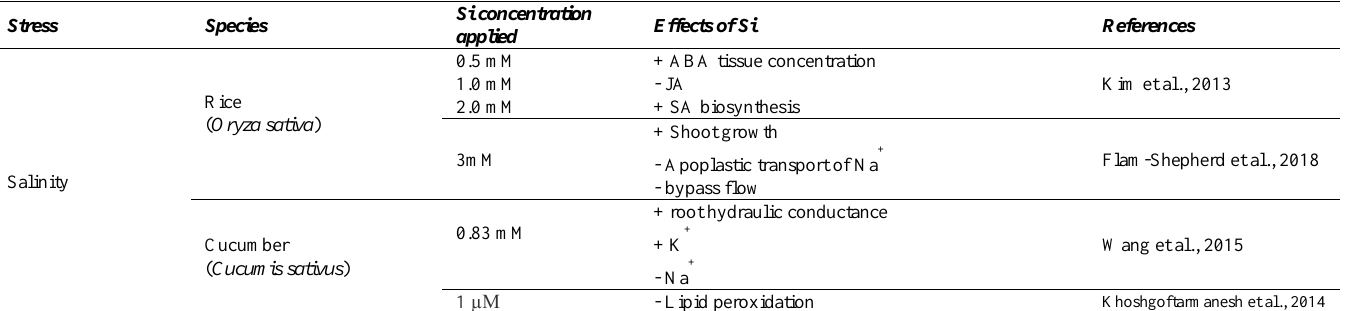
Table 3 . Literature summary on effects of Si in abiotic